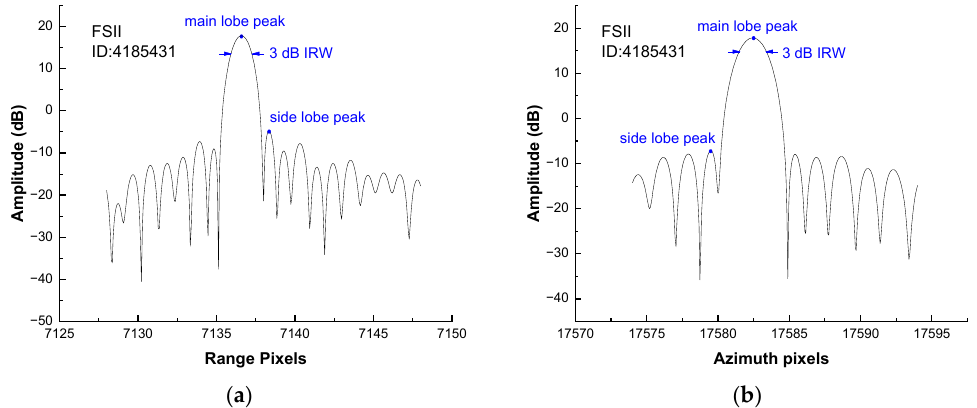
Figure 5. Sample TCR impulse responses in the ( a ) range and ( b ) azimuth directions.